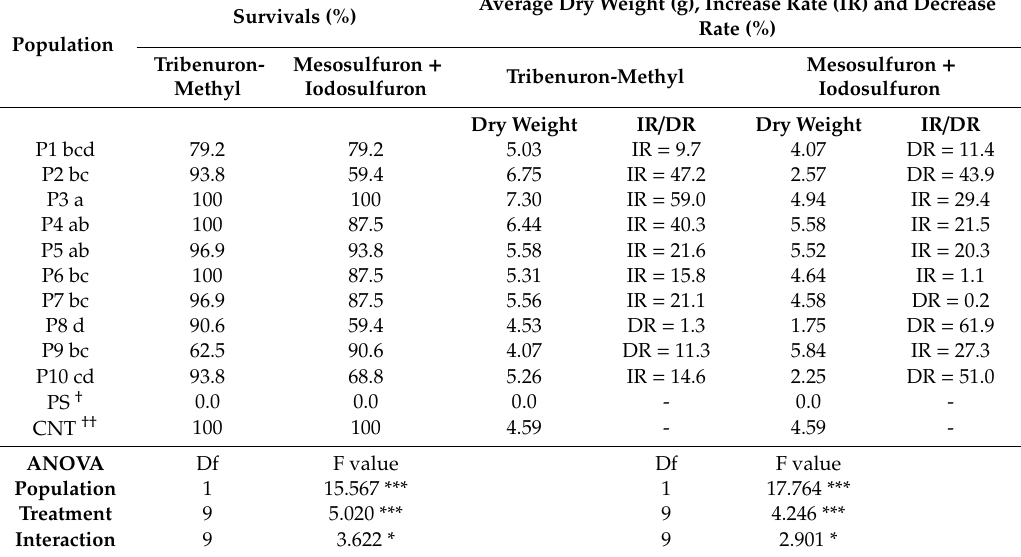
Table 4. Glebionis coronaria survival and average dry weight reduction / stimulation at 28 days after treatment (DAT) after two sulfonylureas herbicides application.